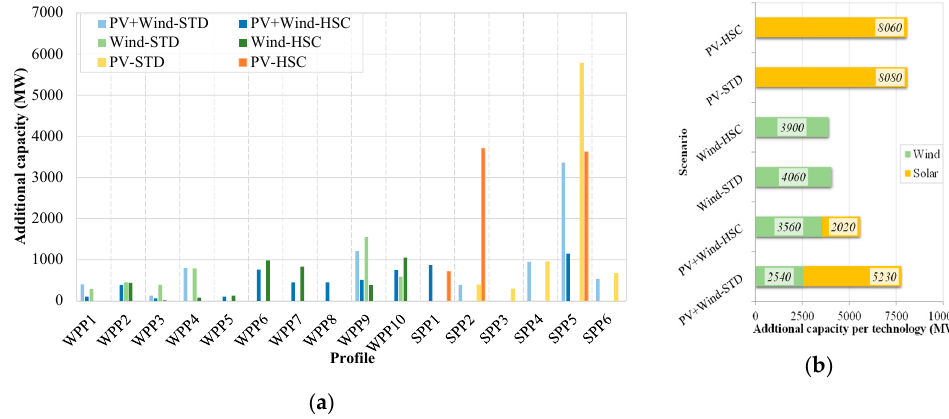
Figure 8. ( a ) Additional power capacity in each region, and ( b ) identification of the wind/solar PV power capacity in each scenario and optimization perspective.